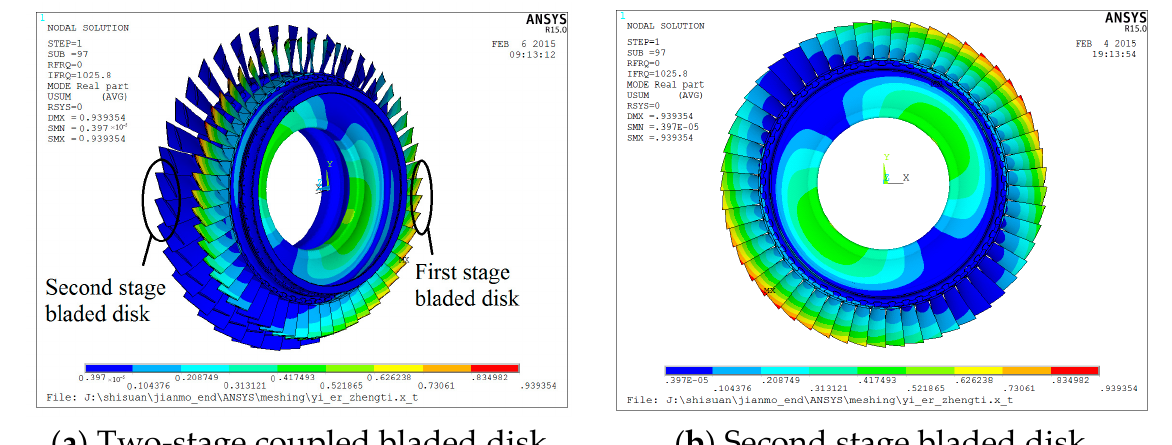
Figure 20. Coupled vibration of the blade and disk with a 0 pitch diameter.